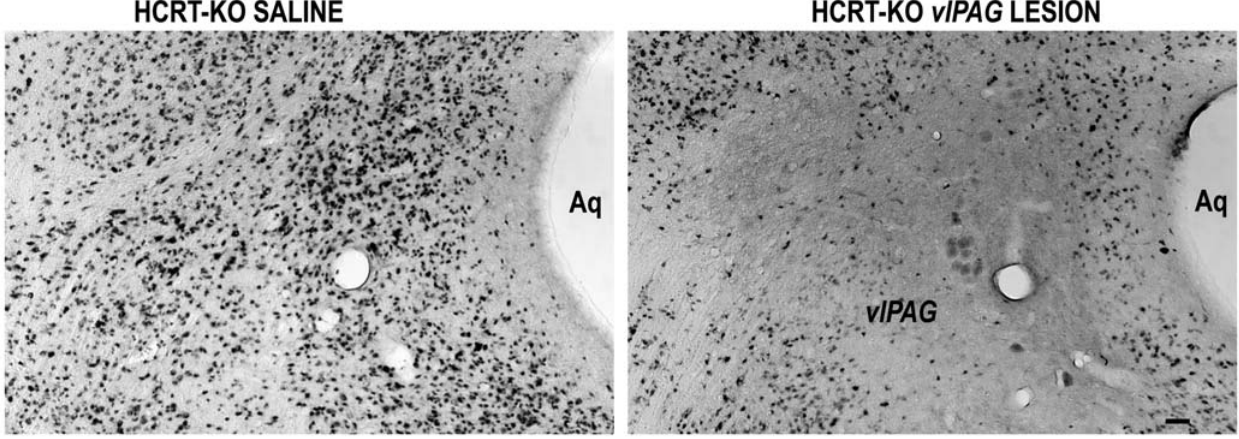
Figure 2. Photomicrographs of NeuN staining in the control (saline injected) and lesioned (HCRT2-SAP injected in the vl PAG) HCRT - ko mice. Compare with figure 9A which shows the localization of eGFP neurons in the vl PAG. Scale bar 2 50 m m.